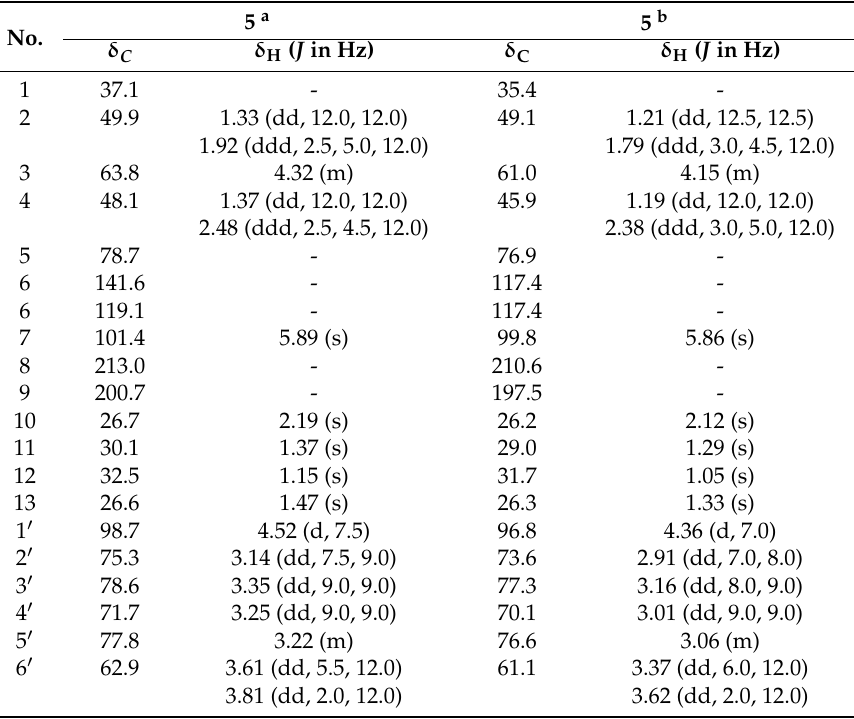
Figure 7. The main 1 H- 1 H COSY, HMBC, and NOE correlations of 5 . Table 5. The 1 H- and 13 C-NMR data of 5